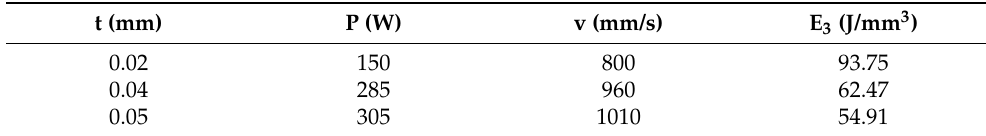
Table 3. Table of process parameters by EOS GmbH.